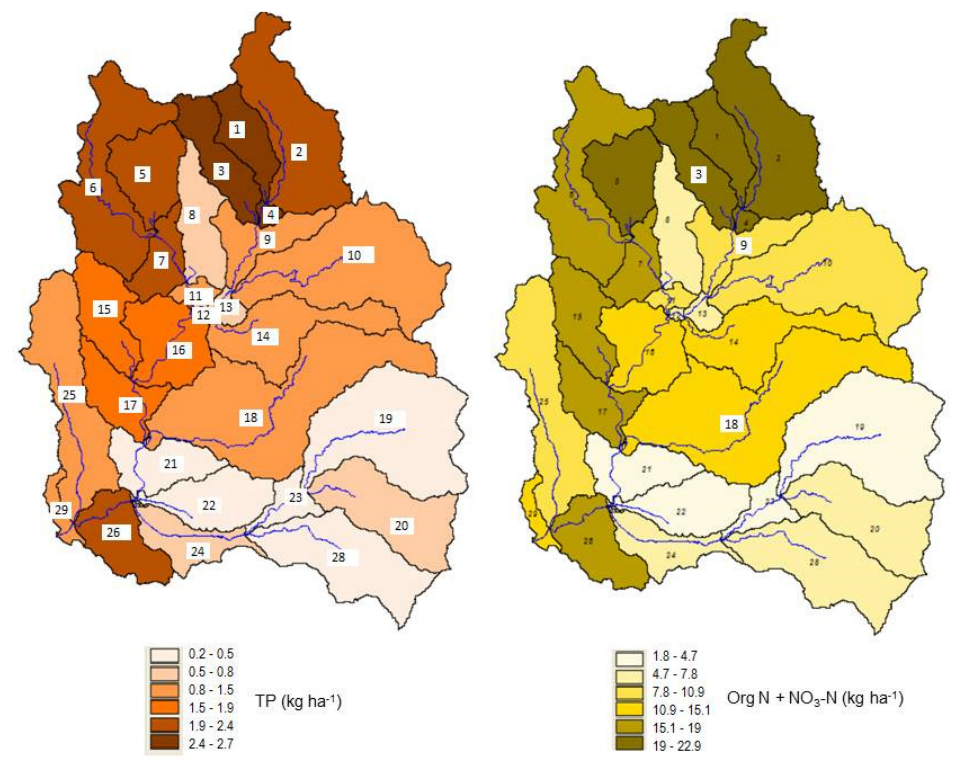
Figure 3. Average annual load of TP (kg ha − 1 year − 1 ) and organic N + NO 3 -N (kg ha − 1 year − 1 ), simulated at the sub-basin scale.